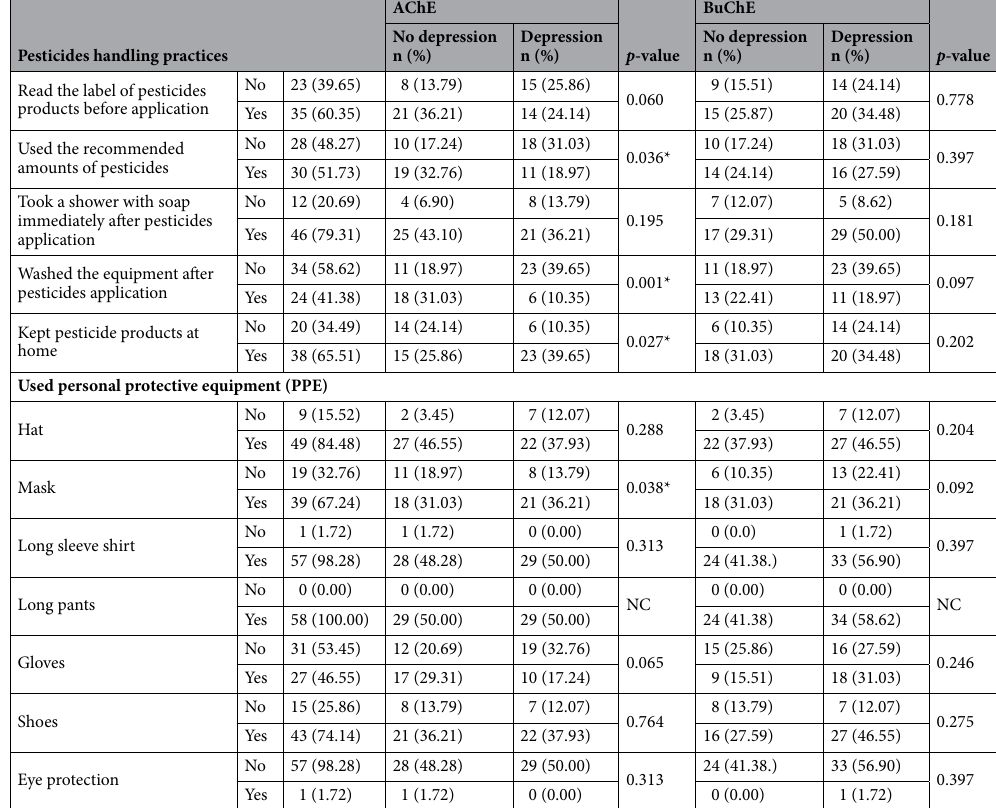
Table 2. Pesticides handling practices.